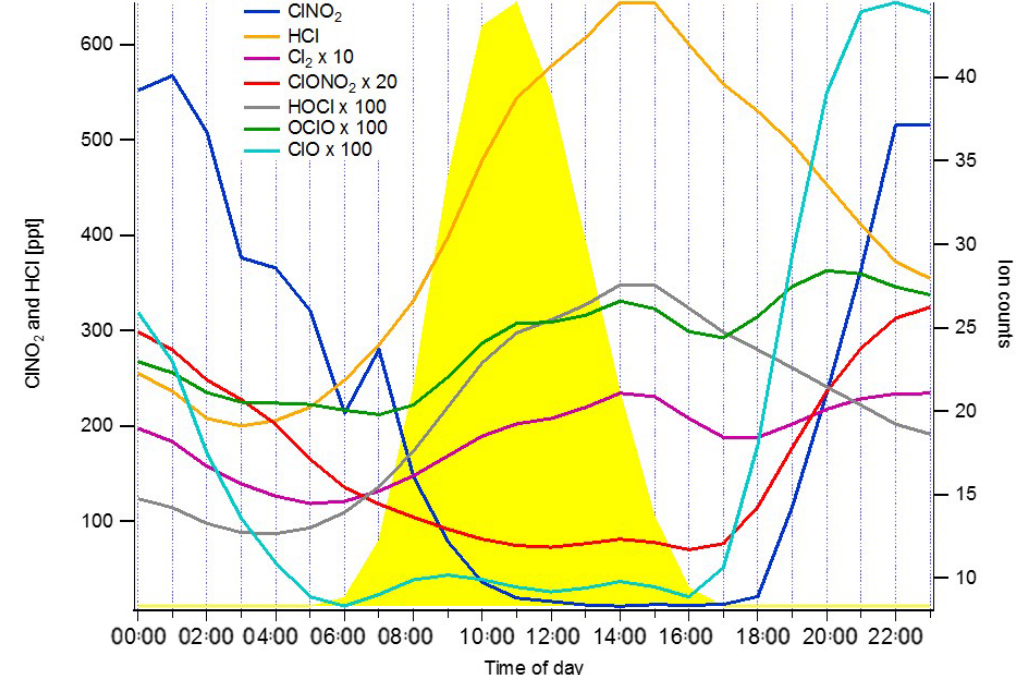
Figure 3. Mean diurnal profiles of the inorganic halogens detected by the CIMS from the 23 May to 6 June with average J rate for ClNO 2 as guide for photolysis. ClNO 2 and HCl mixing ratios are on the left y axis and the other inorganic halogens on the right y axis displayed in ion